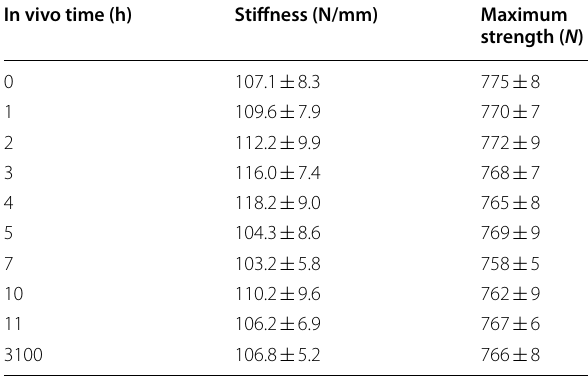
Table 5 Mechanical properties of flexural strength at 30 °C of the zirconia dental implants at different ageing